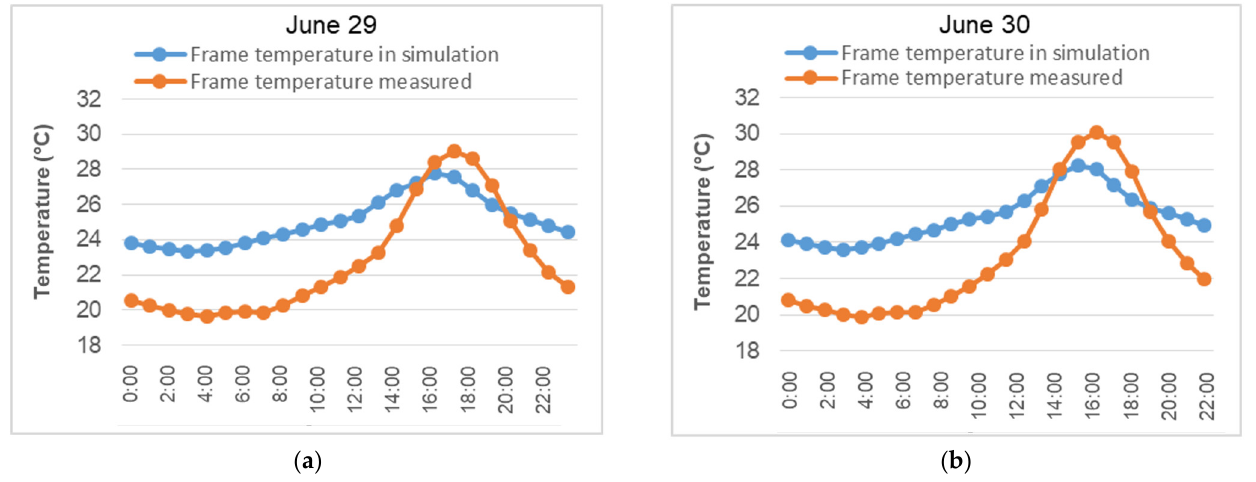
Figure 10. Comparison of all-day surface temperature profiles on a window frame from measured values with simulation: ( a ) for 29 June, ( b ) for 30 June.